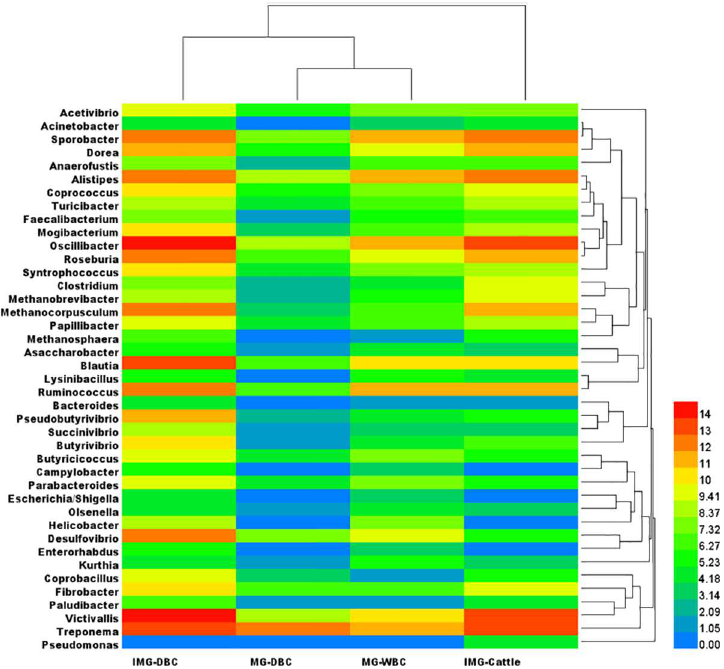
Fig 2. Heatmapof the relative abundance of bacterial genera in fecal samples. Blue represents the minimumrelative abundance and red the maximum.